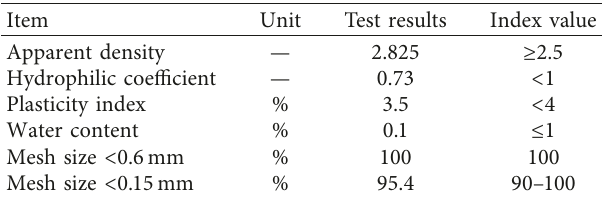
Table 4: Technical indexes of mineral